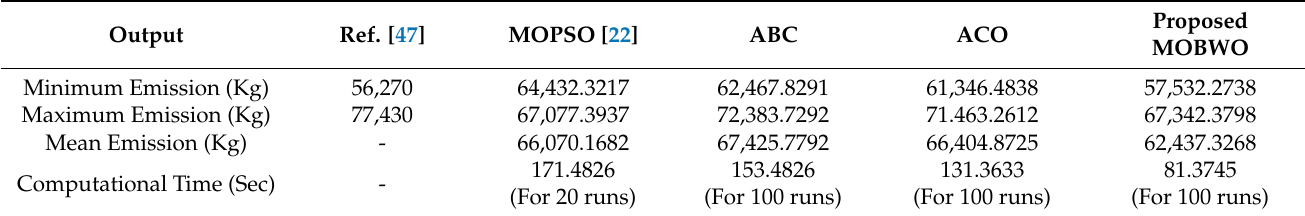
Table 8. Comparison of emissions with different techniques for Case